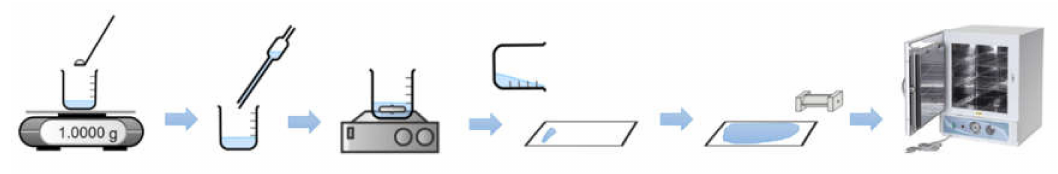
Figure 1. Schematic representation of the procedure used in the processing of the poly( l -lactic acid) (PLLA) and PLLA / [Emim][TFSI]